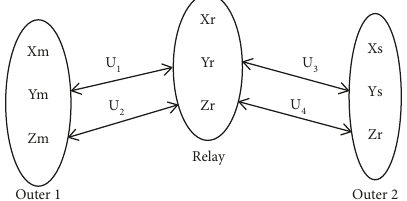
Figure 7: Schematic diagram of the relay coupling of the three three-dimensional autonomous systems with a parabolic